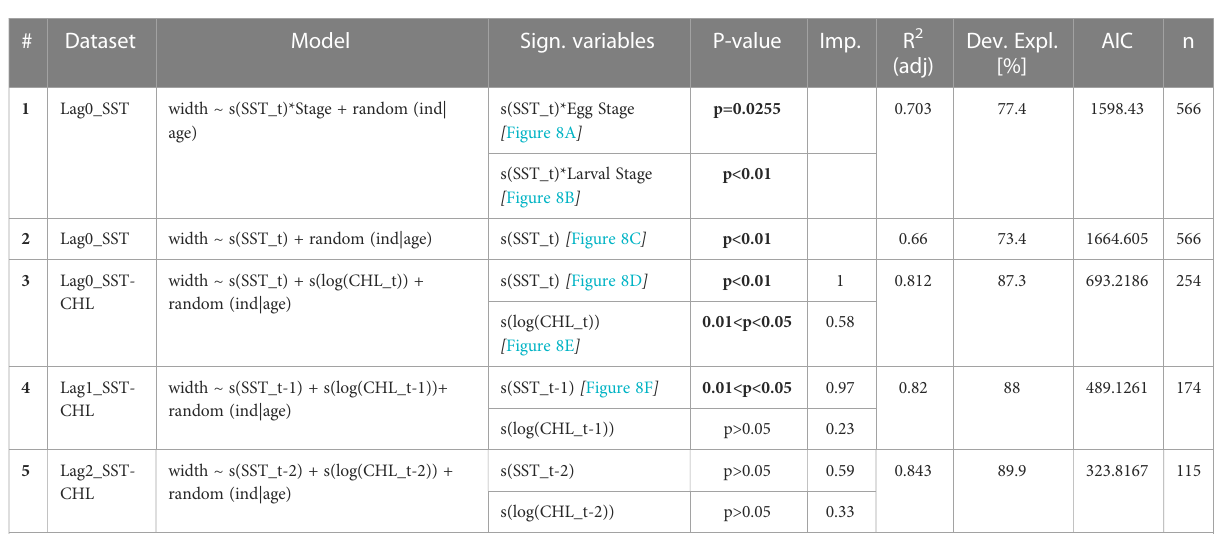
TABLE 2 Outcomes of the GAMMs including the individual factor as random intercepts and the age as random slopes [in the model: random(ind| age)]. # Dataset Model Sign. variables P-value Imp. R 2